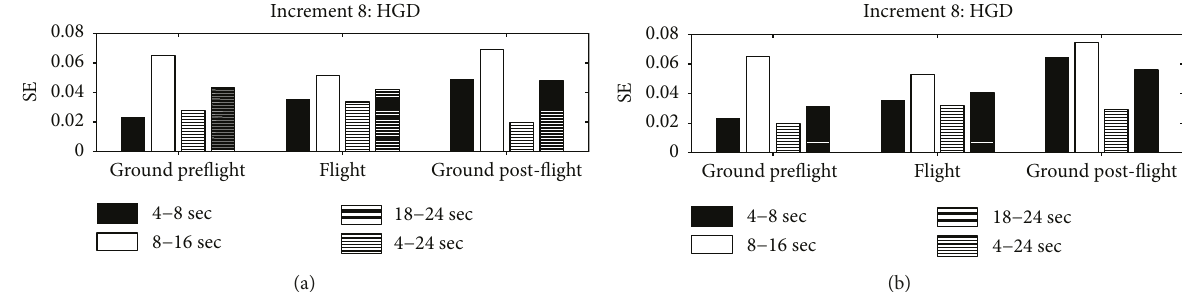
Figure 3: Static e ff ort (SE). (a) Trend for increment 8 in handgrip dynamometer (HGD) tests. (b) Trend for increment 8 in pinch force dynamometer (PFD) tests. Average values of pre fl ight, fl ight, and post fl ight are reported.